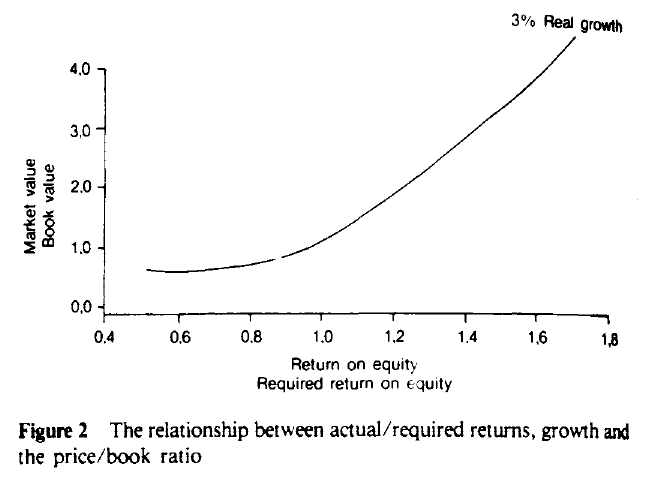
Figure 2 The relationship between actual/required returns, growth and the price/book